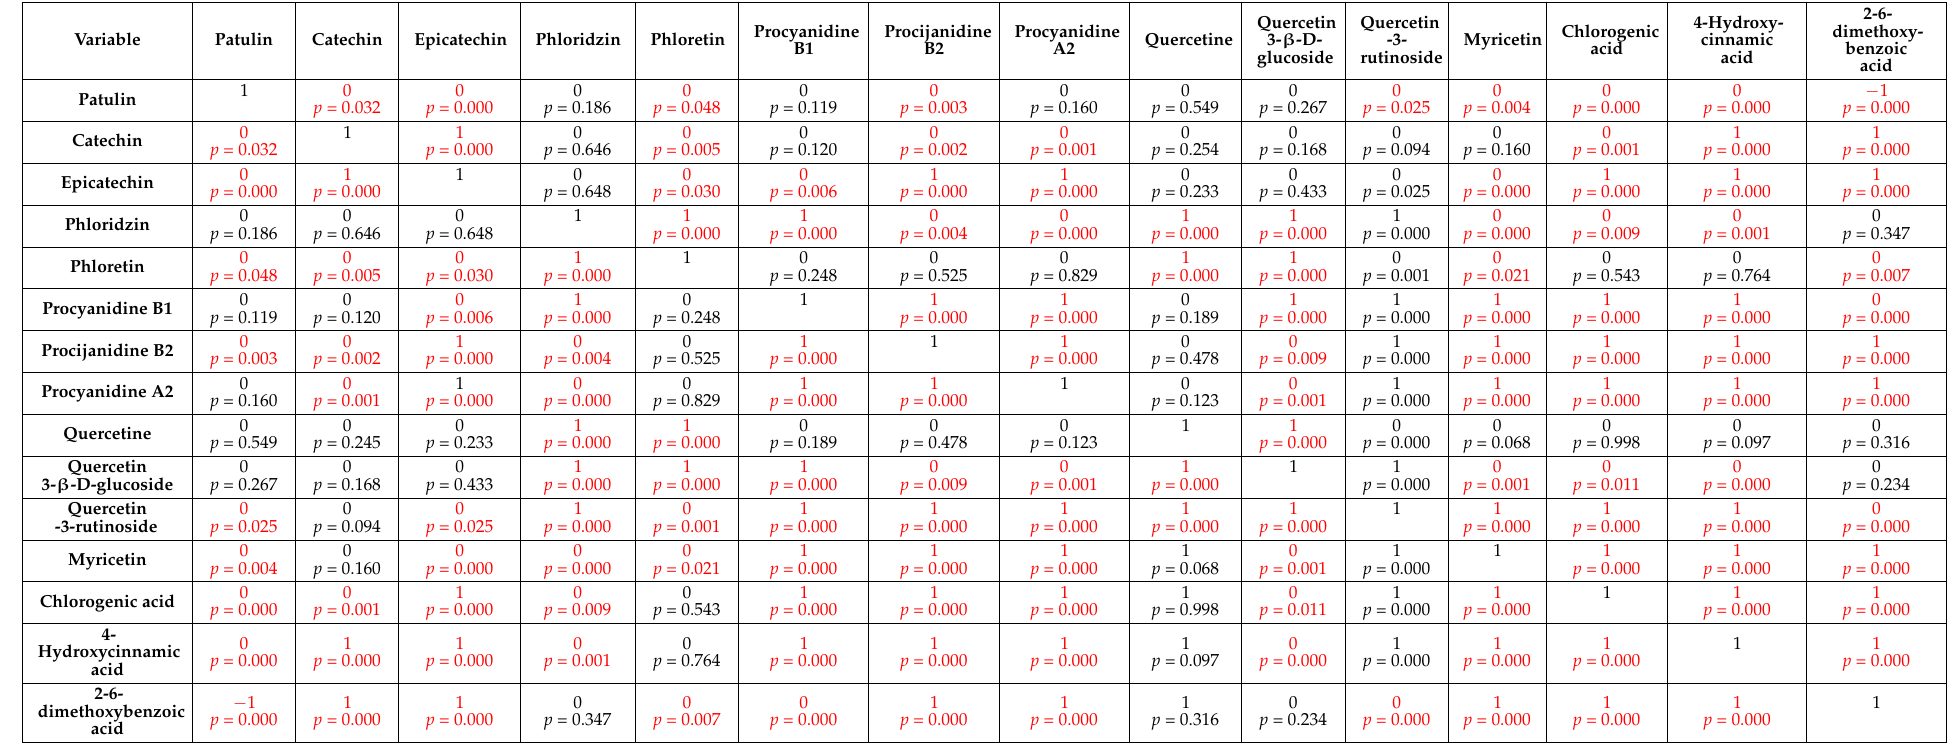
Table A1. The p -values of the correlations of patulin with identified polyphenols. The p -values of the correlations of patulin with identified polyphenols. Statistically significant p -values are marked red ( p <